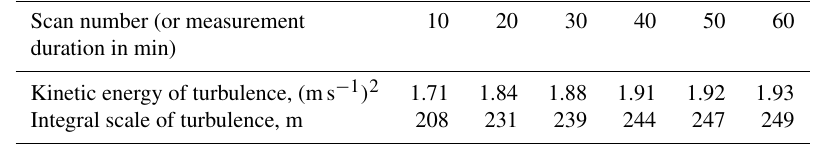
Table 1. Average estimates of the kinetic energy and the integral scale of turbulence as functions of the number of scans used during the lidar measurements in the period from 12:00 to 18:00LT on 22 July 2016 at a height of 200m.